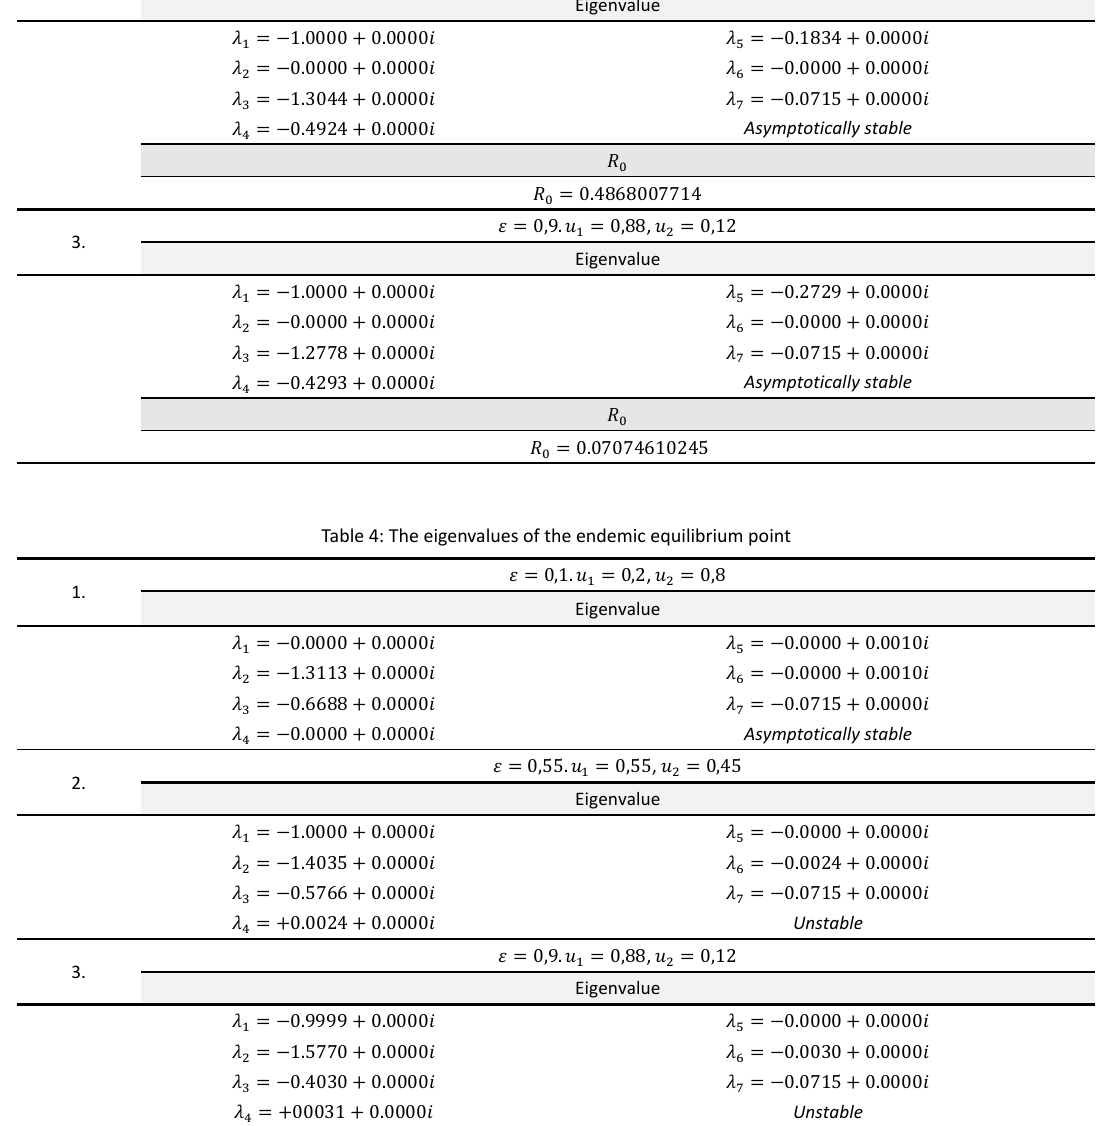
Table 3: Eigenvalues and